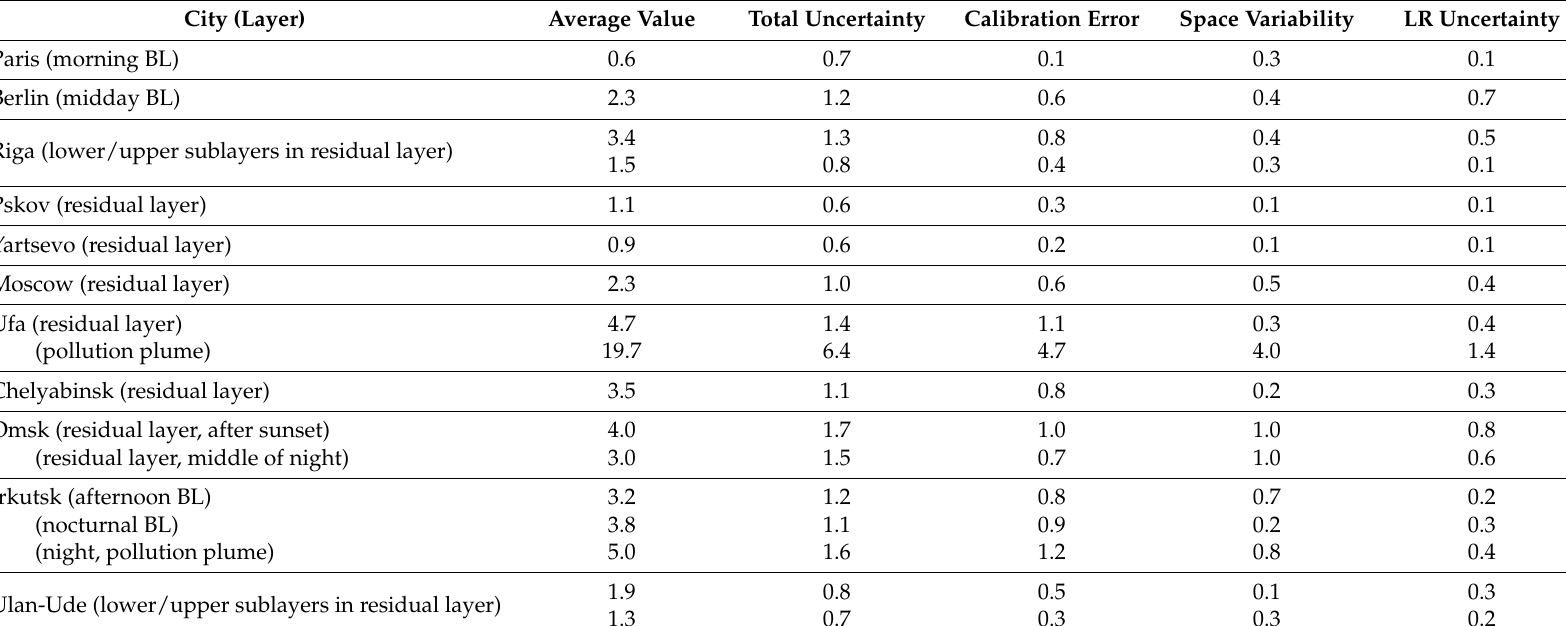
Table A2. Error budget on the PDR values presented in Table 2, following the process described in Section 3.2. All values are in percent. Columns 3 to 6 are all absolute uncertainties. As the laser residual polarization was considered to represent a constant 0.5% bias, it is not mentioned in this